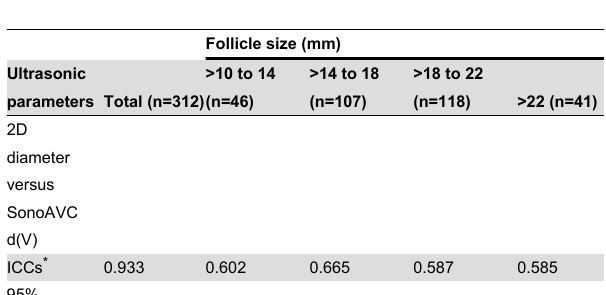
Table 2. The ICCs of 2D measurement and SonoAVC in various follicle